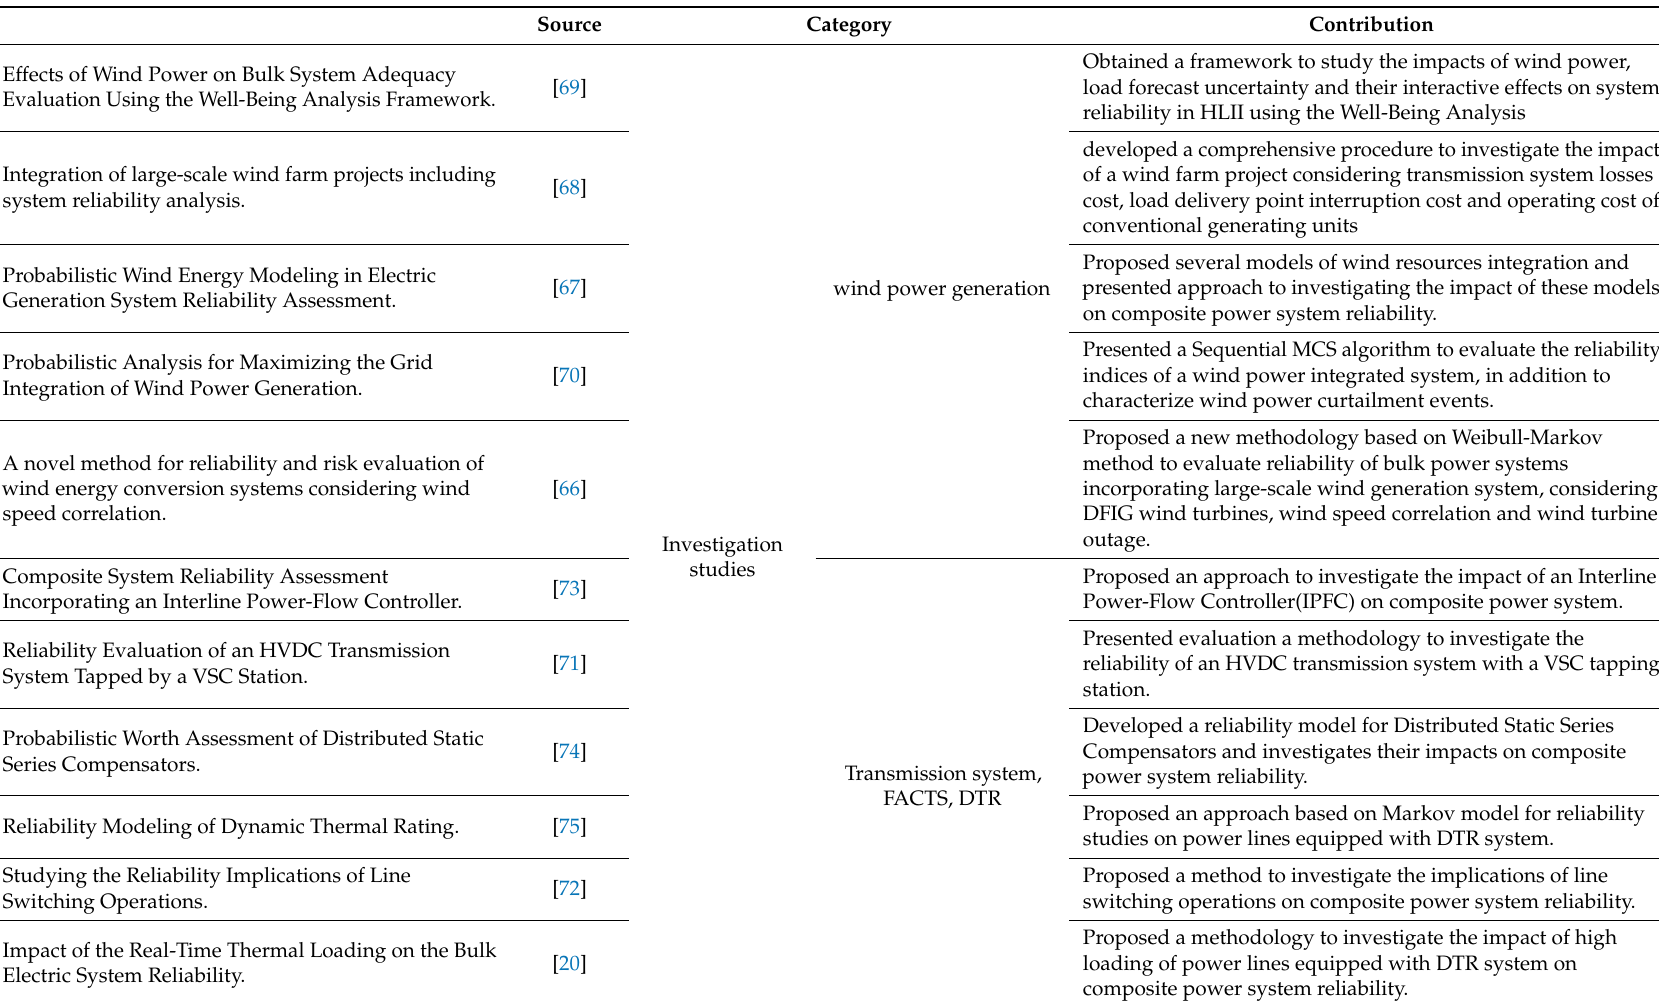
Table 2. Comparison of the notable studies conducted on composite power system reliability